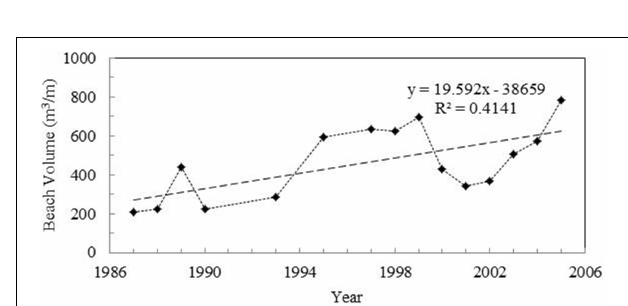
FIGURE 10 | Average annual beach volume per meter width of beach at OWO pier at J-O Coast. Broken line shows the linear